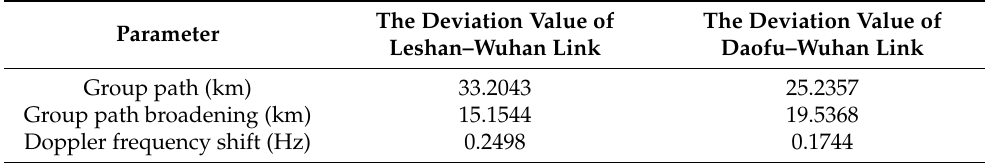
Table 2. The deviation of the difference between the simulation results and the experimental